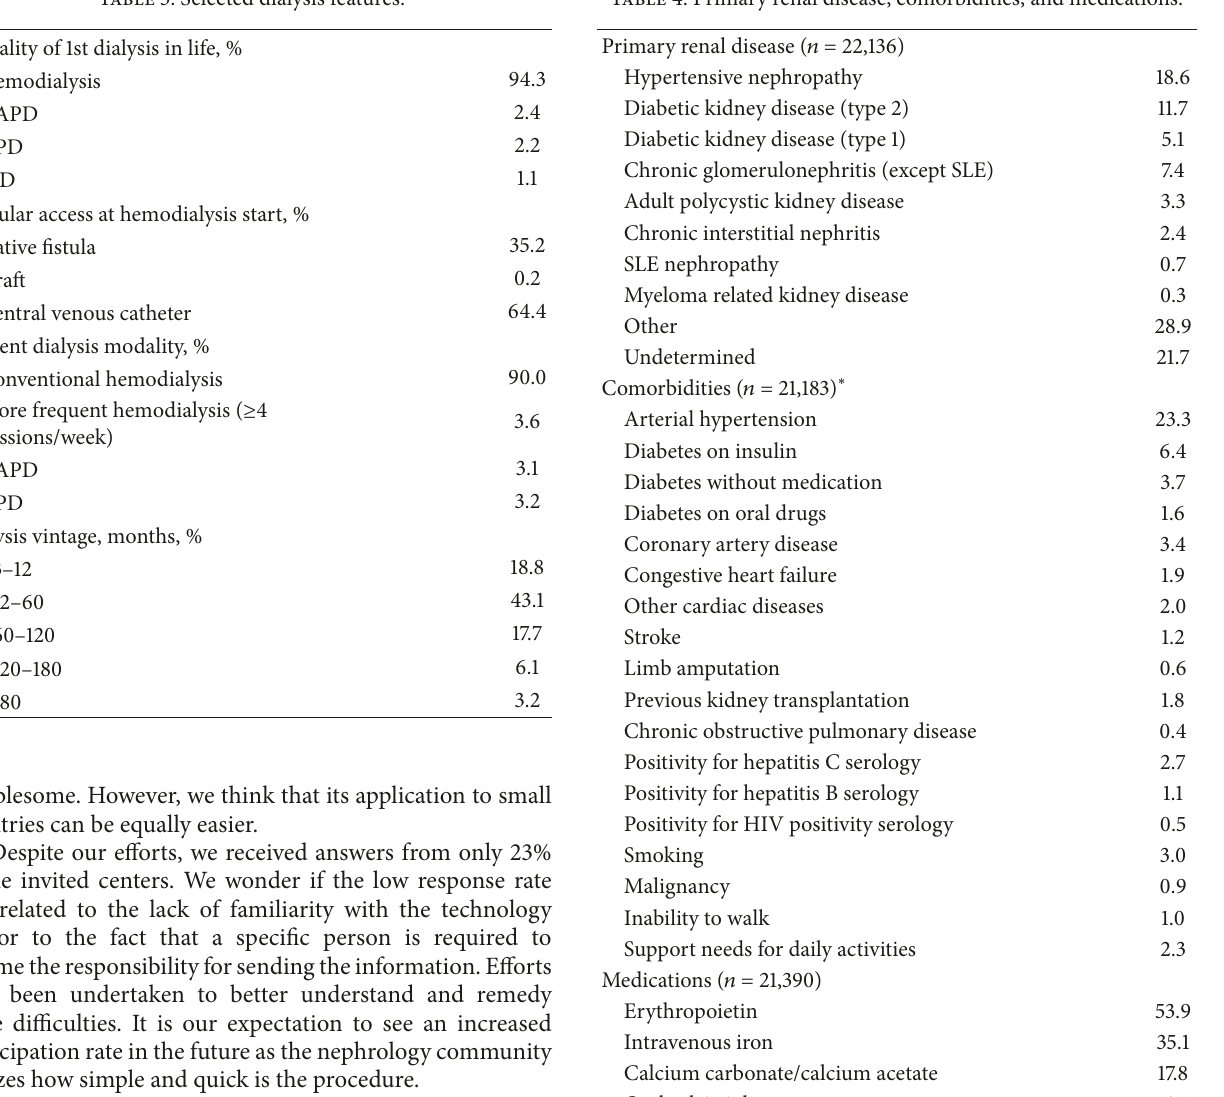
Table 3: Selected dialysis features. Table 4: Primary renal disease, comorbidities, and